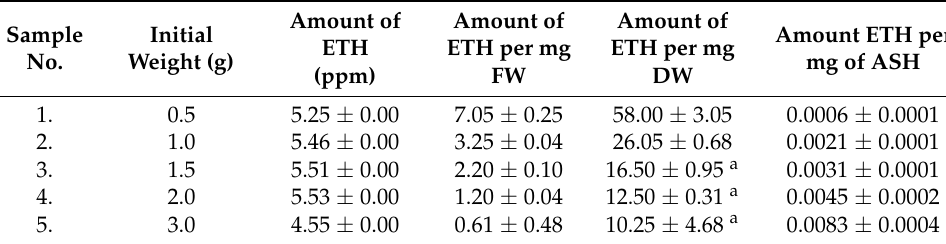
Table 2. Effectivity of ETH production in relation to the initial weight of used of cell suspension for